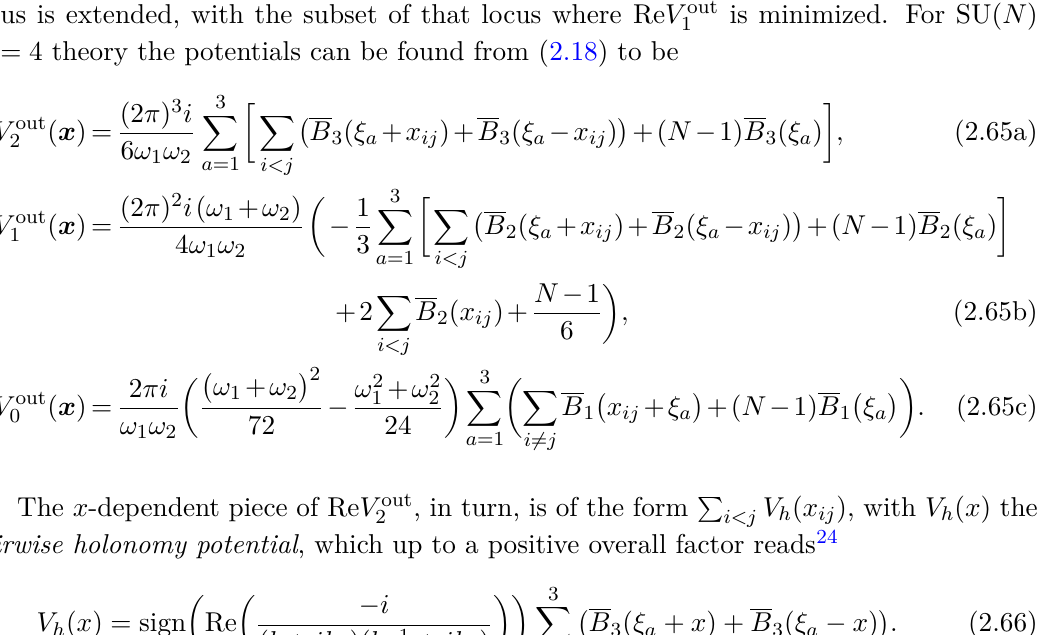
Figure 1 . The decomposition of the classical moduli space h cl for SU(2) N = 4 theory with ξ 1 , 2 , 3 = 0 . In the SU(2) case h cl is parametrized by x 1 ∈ [ − 1 , there are two inner patches, and the outer patch consists of two connected (cid:15) < (cid:15) c = 1 2